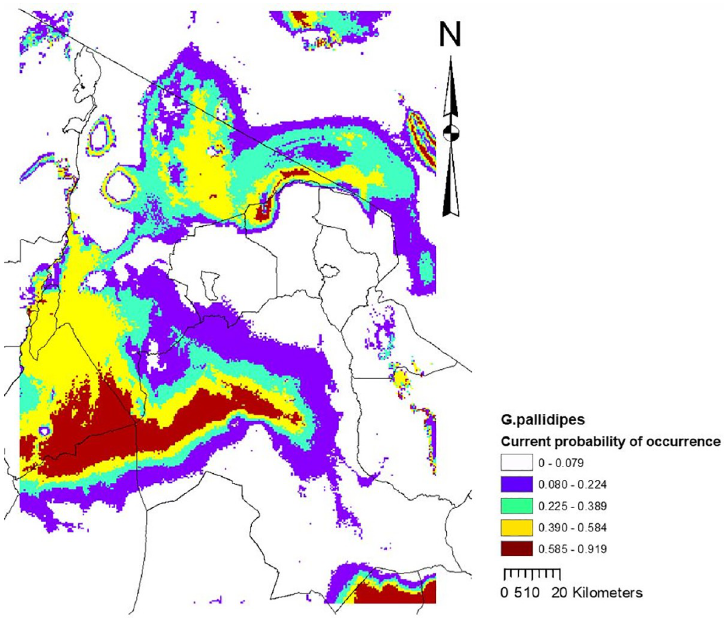
Fig 4. Current climate suitability map for the best performing model with the G . pallidipes occurrence data, including all 4 variables.